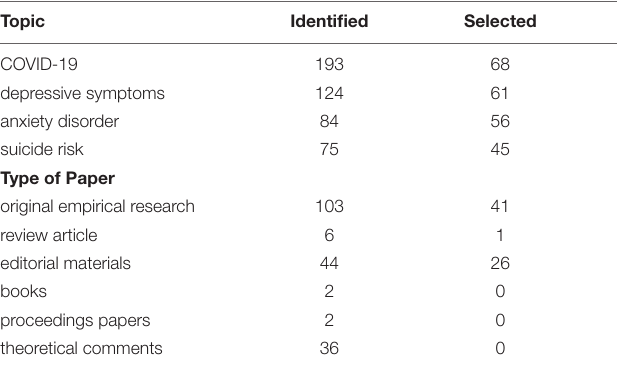
TABLE 1 | Topics and types of papers identified and